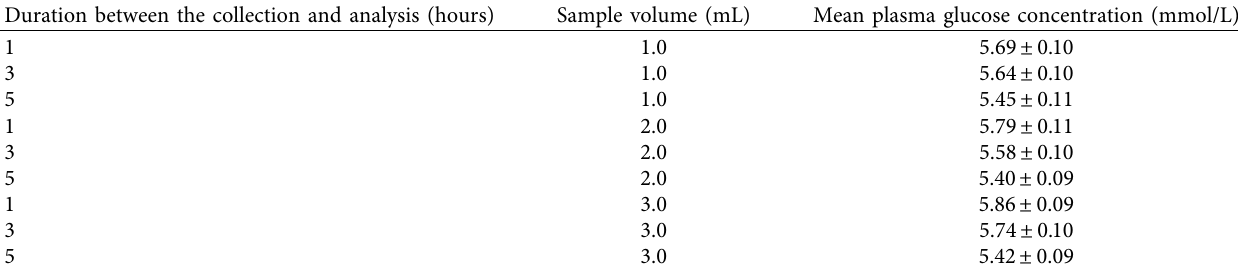
Table 1: Mean plasma glucose concentration in different phases in